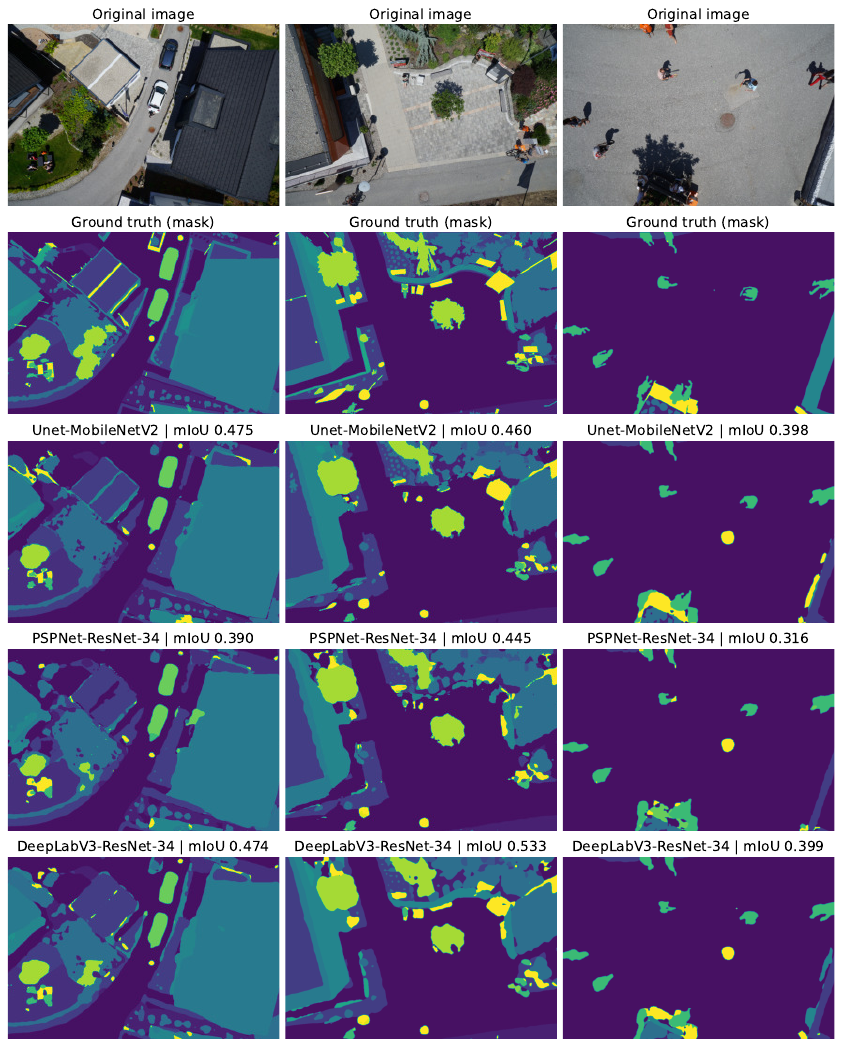
Figure 3. Examples of performance evaluation for pairs of networks Unet–MobileNetV2, PSPNet– ResNet34, and DeepLab–ResNet34. In the upper part of the figure the original images are shown, followed by the markup mask (the reference markup of the corresponding image). Then, the results of the specified pairs of networks are